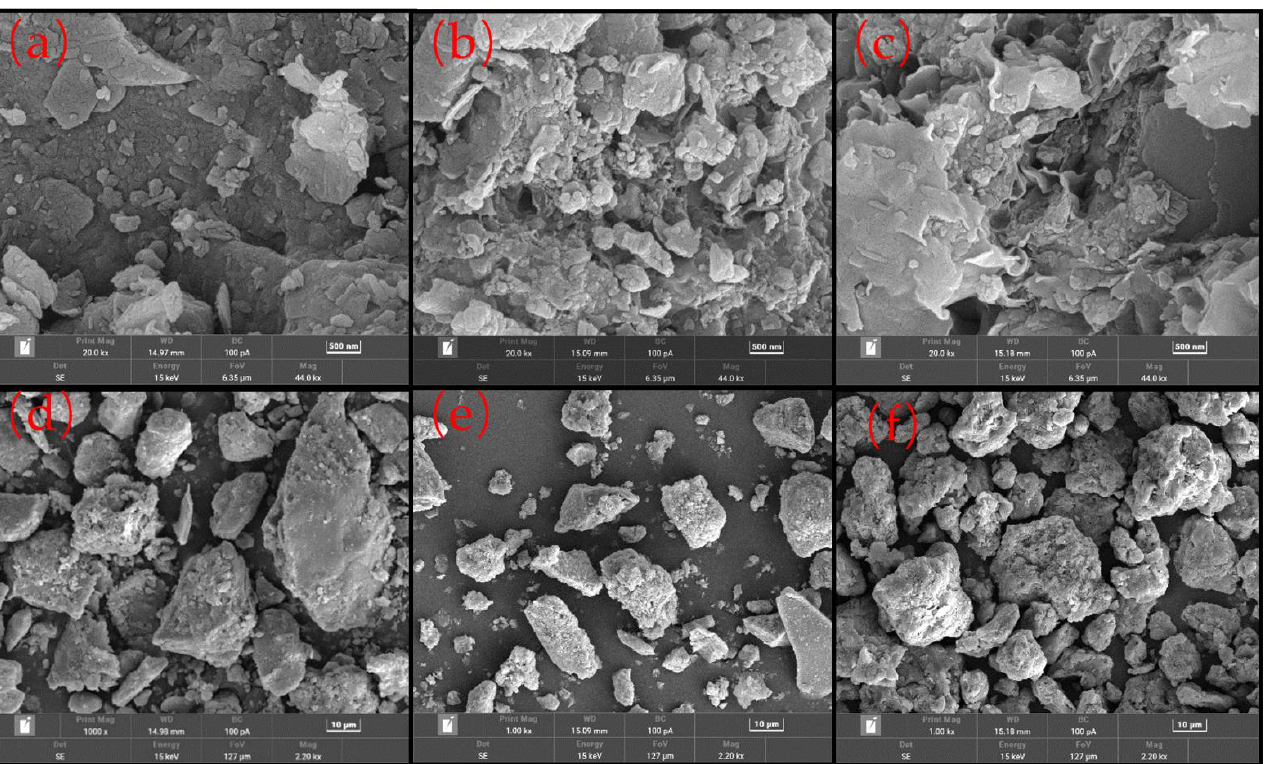
Figure 2. XRD pattern of materials: ( a ) SSTS, silt, and SB; ( b ) M-S.